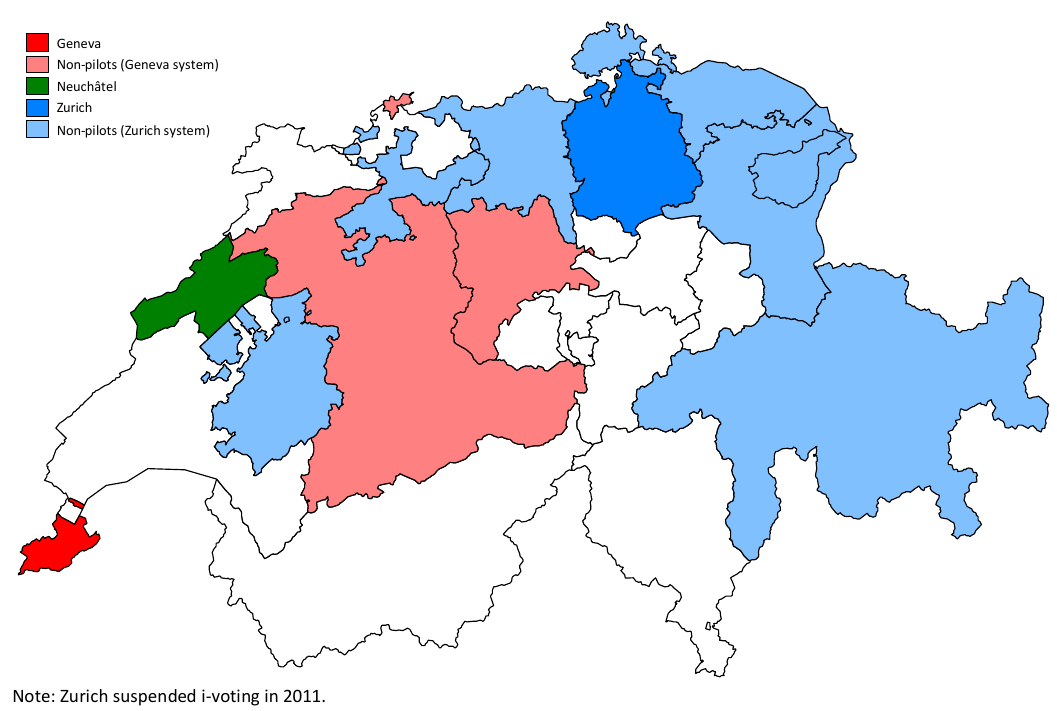
Figure 1: I-voting in Swiss